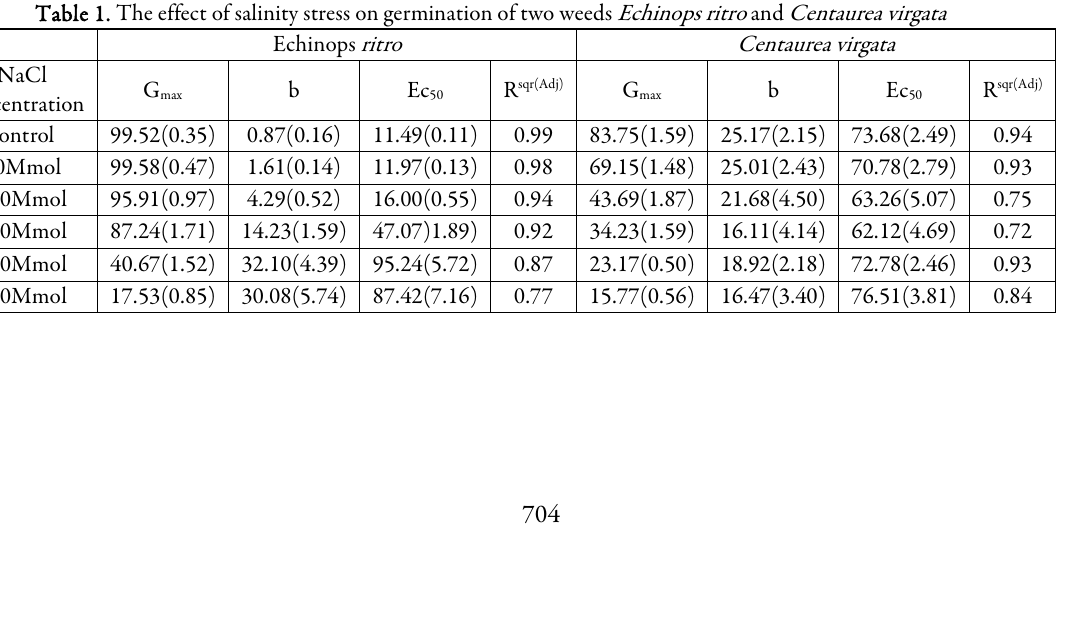
Equation 4: Sigmoid 3 parameter: Y=